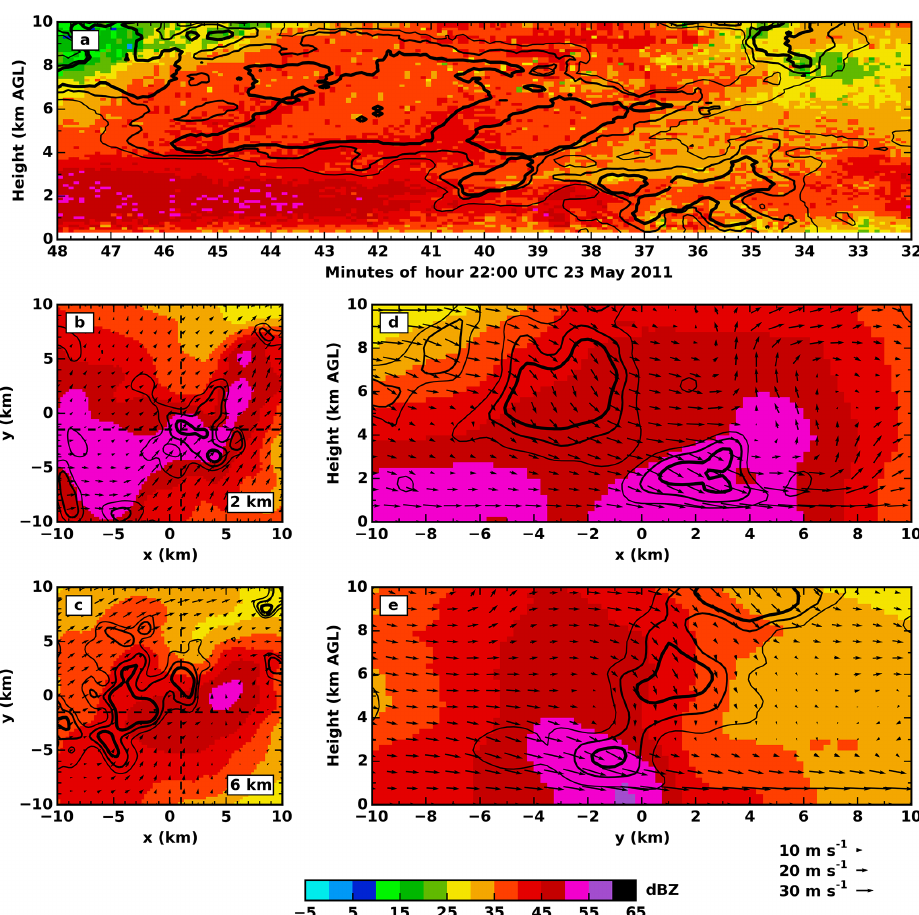
Figure 11. Two independent vertical air motion retrievals on 23 May 2011 from (a) 915MHz radar wind profiler (UAZR-I9) and (b– e) 3DVAR. Radar reflectivity background and vertical velocity contours of − 4 (light), − 6 (medium), and − 8ms − 1 (thick) are shown in all panels. Wind vectors are shown in all 3DVAR panels. Horizontal cross sections shown in panels (b–c) are at 2 and 6kma.g.l., respectively, with dashed black lines indicating the corresponding vertical cross sections in panels (d–e) . The 3DVAR retrieval was derived from scanning radar observations recorded between 22:36 and 22:43UTC. The origin in panels (b–e) corresponds to the location of